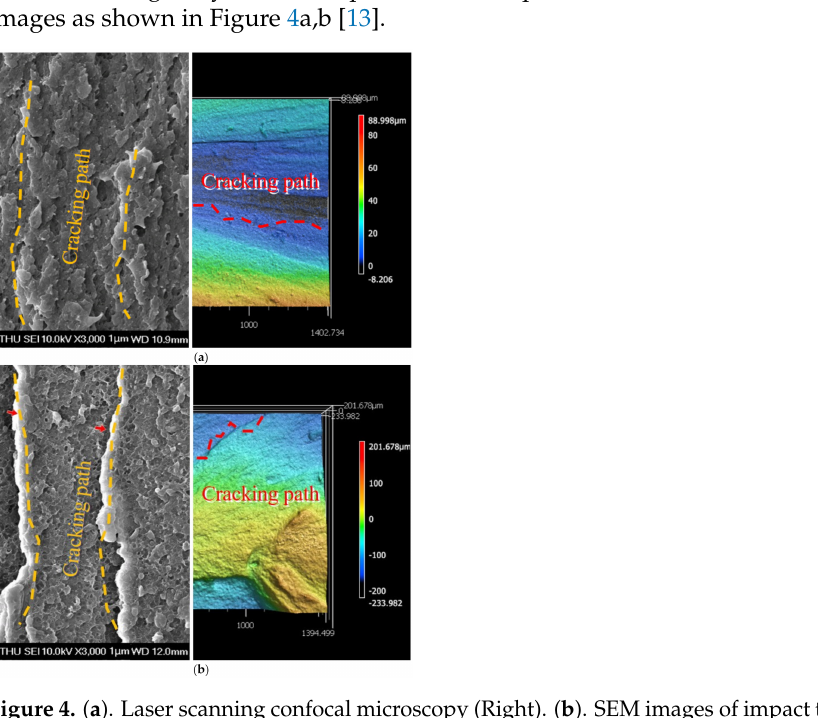
Figure 4. ( a ). Laser scanning confocal microscopy (Right). ( b ). SEM images of impact tested specimen showing the crack path [13] Reproduced with permission from